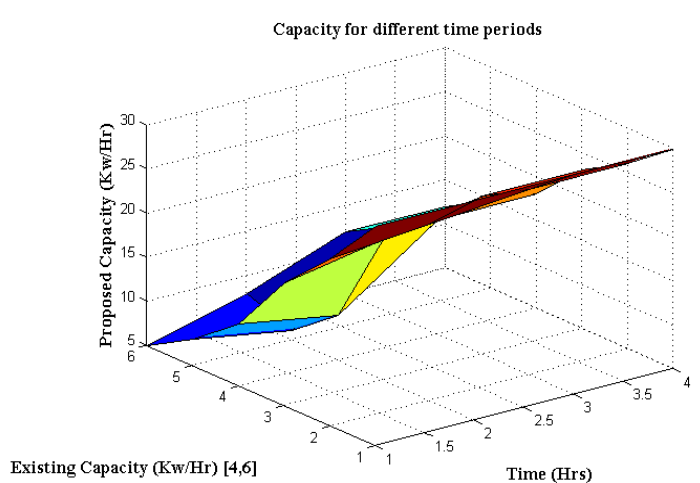
Figure 3. Estimation of capacity for different time periods.